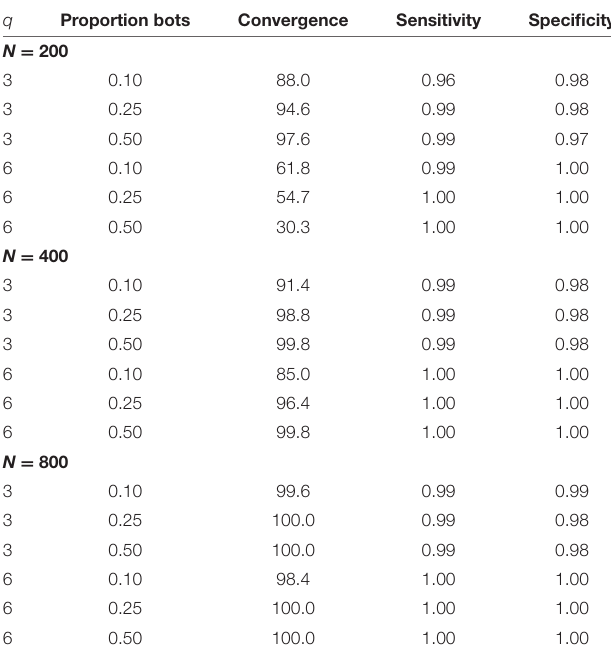
TABLE 2 | Convergence rates as well as sensitivity and specificity for the recovery of class memberships for the LC-CFA across conditions of sample size ( N ), number of factors ( q ), and proportion of